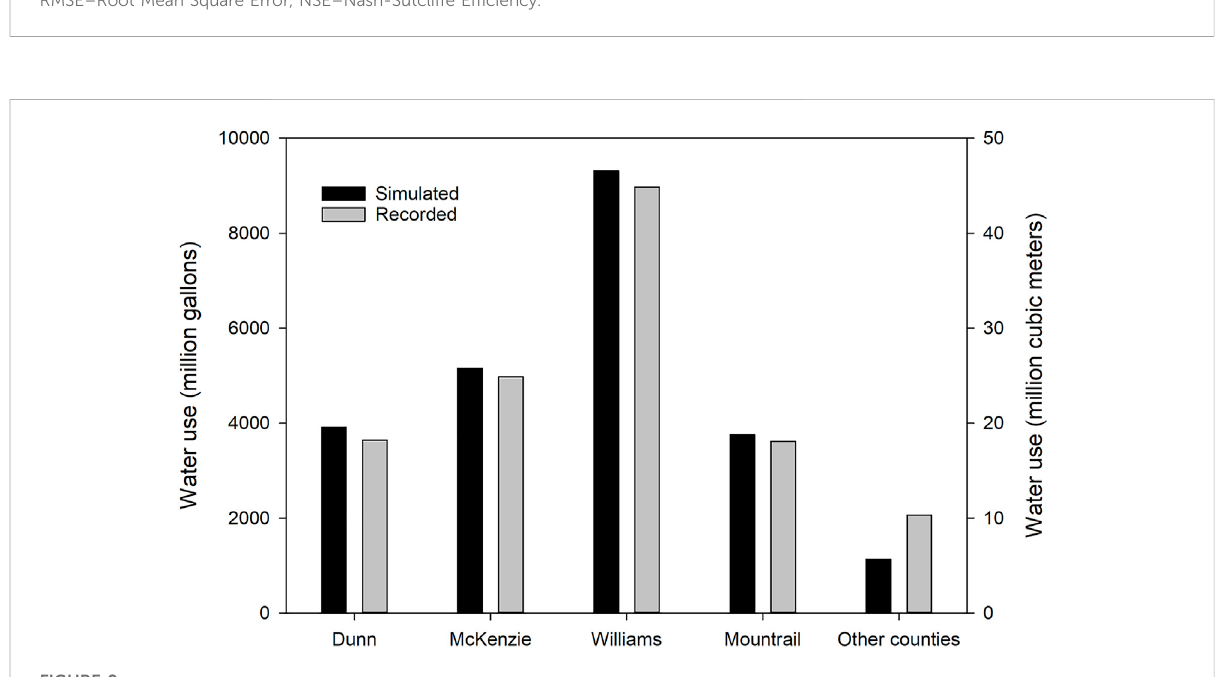
FIGURE 8 Graphical comparisons of water use for the actual and model-simulated water depots in the four core counties and the other counties in western North